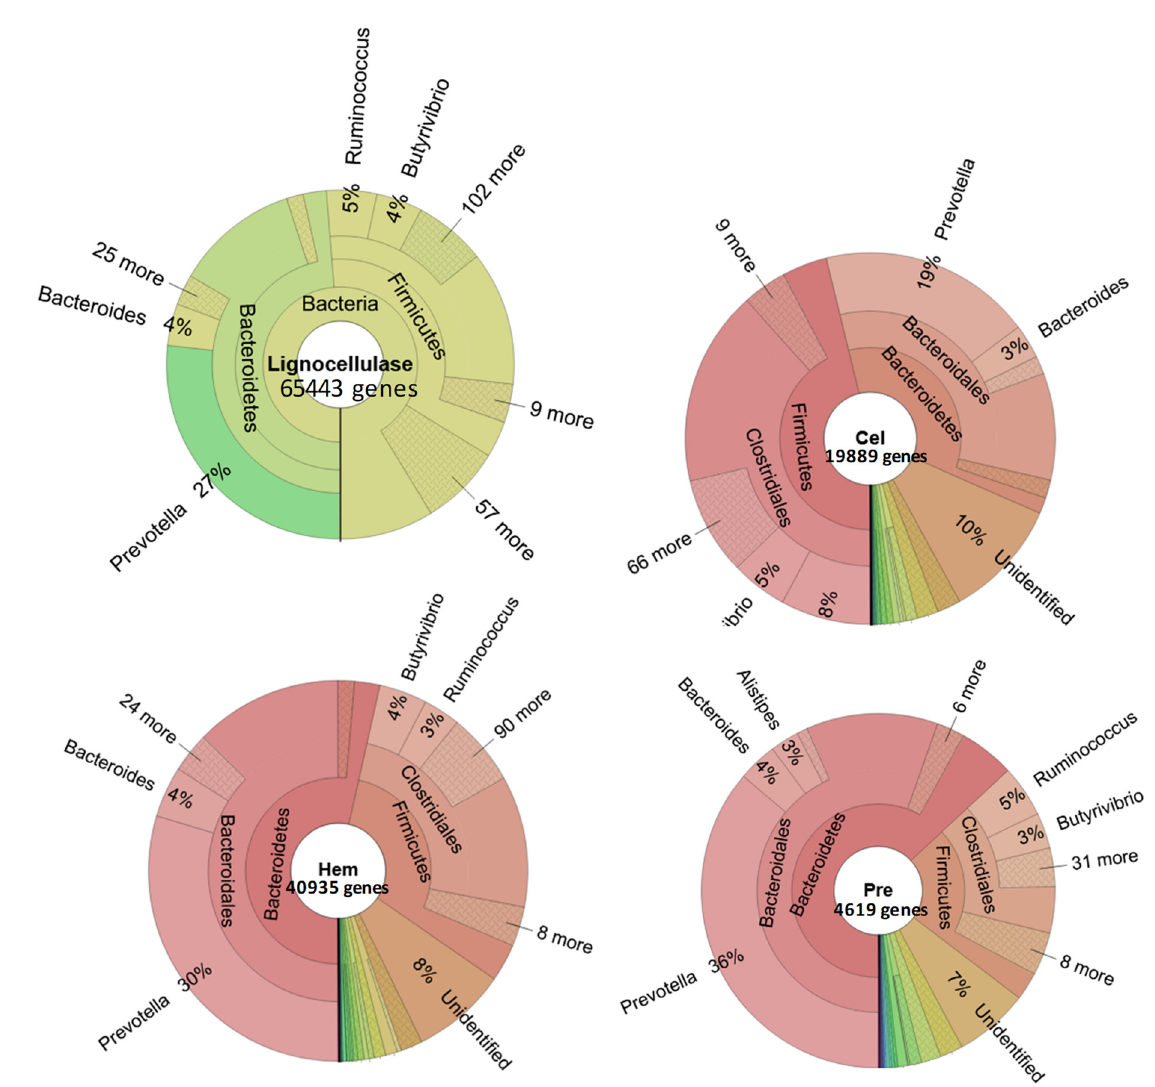
Figure 3. Bacterial contribution for gens coding for enzymes/proteins participated in lignocellulose digestion in Vietnamese goats’ rumen that were annotated by KEGG and taxonomic classification by MEGAN. Cel: genes coding for cellulases; Hem: genes coding for hemicellulases; Pre: genes coding for proteins/enzymes involved in lignocellulose pretreatment.